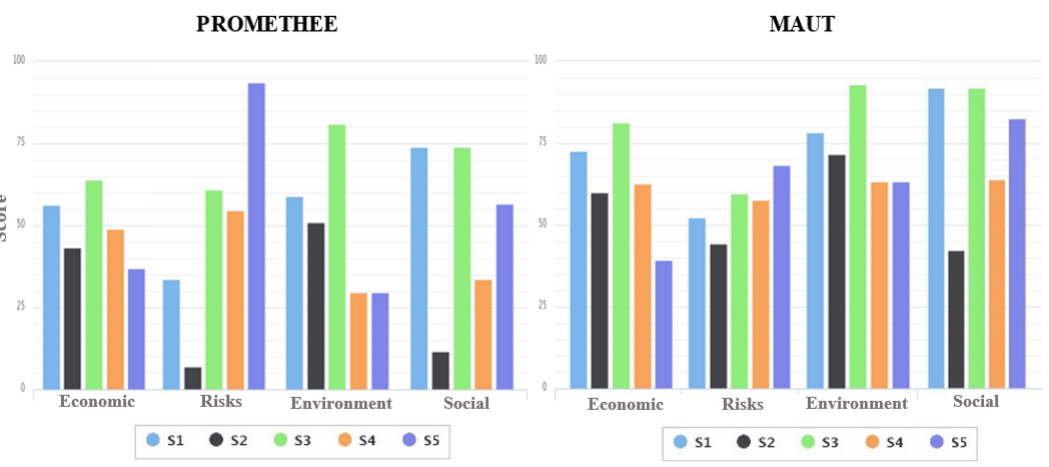
Figure 5. Supplier profiles by criteria dimensions generated by PROMETHEE and MAUT.